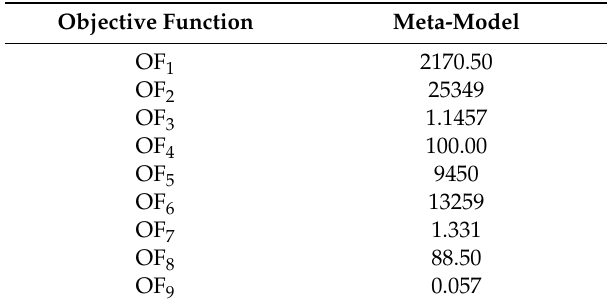
Table 5. Objective functions of the solution obtained using the weighted sum method from the Pareto domain; F P = 210.0 kmol / h, F A = 1636.5 kmol / h, F S1 = 495.74 kmol / h, F S2 = 100.0 kmol / h, T 1 = 628.46 ◦ C, T = 570.79 ◦ C, P = 3.66 bar, and P = 6.00 2 1 2